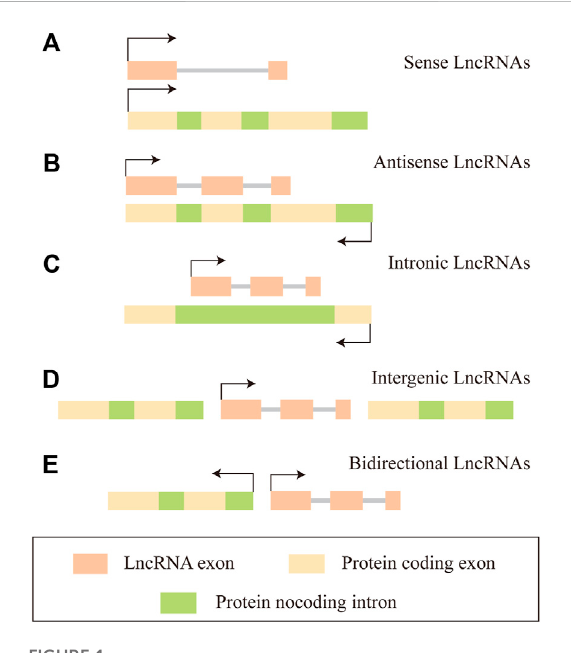
FIGURE 1 The classi fi cation of Long non-coding RNAs (LncRNAs). (A) Sense LncRNAs, it is transcribed by sense chain of protein coding gene, overlaps with at least one exon of protein coding gene on thesamechain. (B) AntisenseLncRNAs,itistranscribedbythe complementary DNA strand of protein coding gene, overlaps with at least one exon of the positive gene. (C) Intronic LncRNAs, it is located in the intron region of a protein coding gene without overlapping with its exons. (D) Intergenic LncRNAs, it is located between two protein coding genes and can be transcribed independently. (E) Bidirectional LncRNAs, they share the same promoter with protein coding genes, but the transcription direction is opposite to protein coding